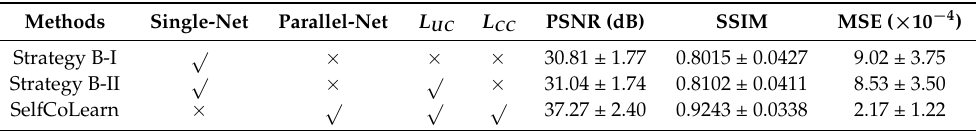
Table 4. Quantitative results of reconstruction models utilizing different training strategies at 8-fold acceleration (mean ±